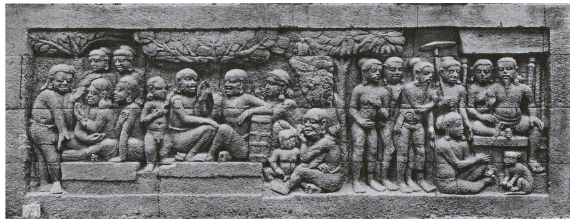
Figure 6. An example of the 2D monocular photos taken